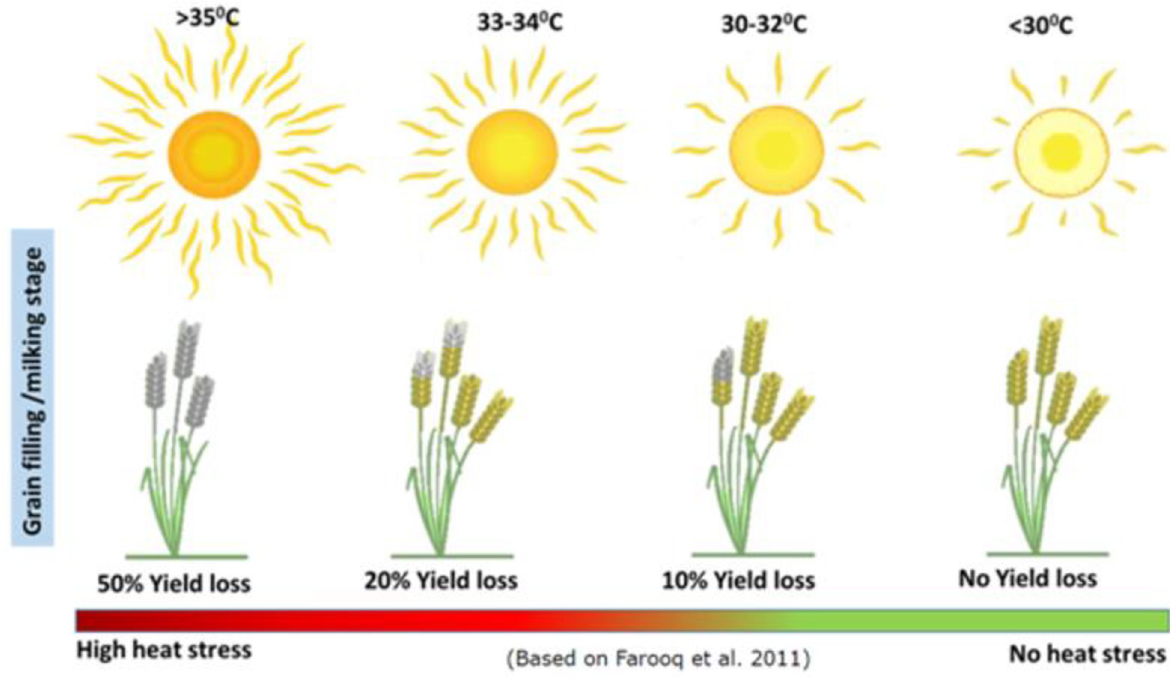
Fig 1. Information priming on the impact of late heat stress in wheat. Note : Developed by Sreejith Aravindakshan, based on Farooq et al. [67].